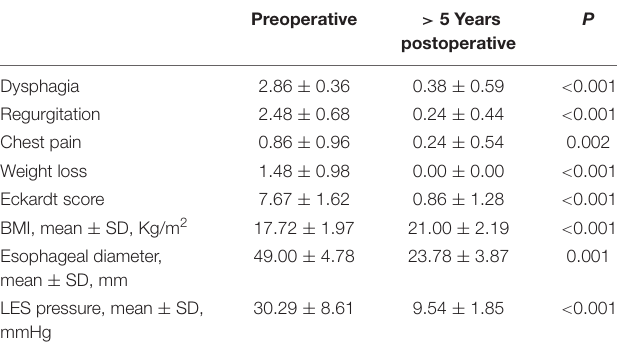
With 3 patients having paired barium esophagram results and 9 patients having paired esophageal manometry results, there were no significant differences in Eckardt score, LES pressure, and esophageal diameter between 6 months and 5 years postoperatively ( Supplementary Table 1